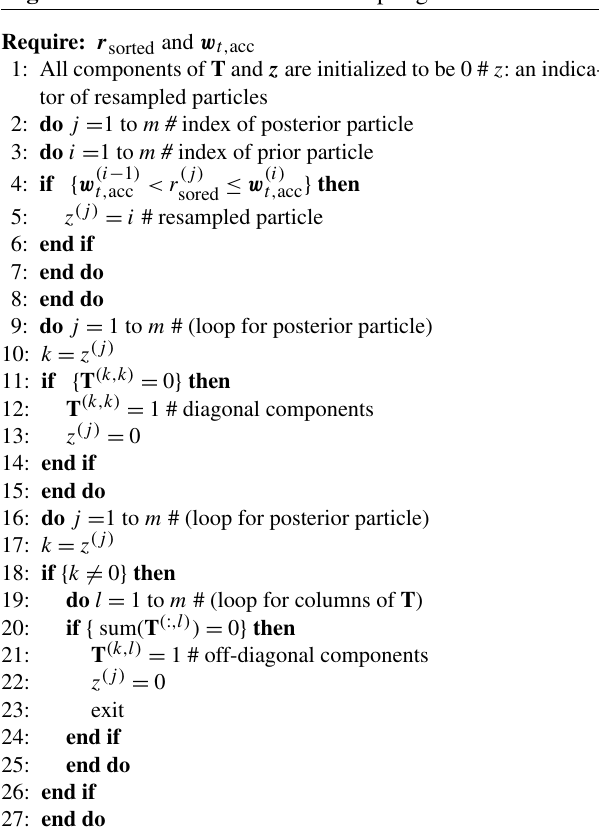
Algorithm 1 Generation of the resampling matrix T